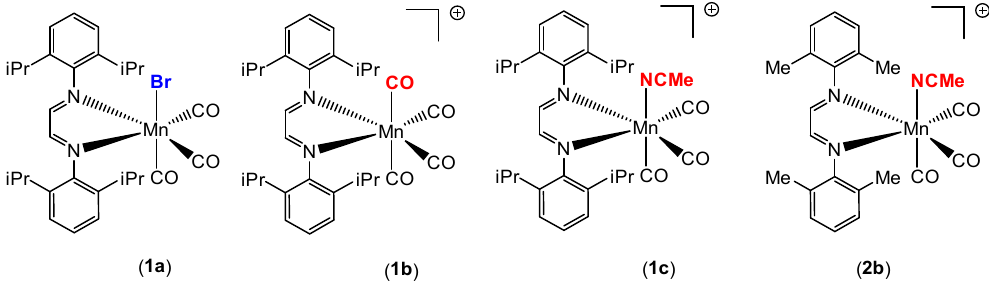
Figure 1. Manganese carbonyl catalysts employed in the hydrosilylation of aldehydes in this work.